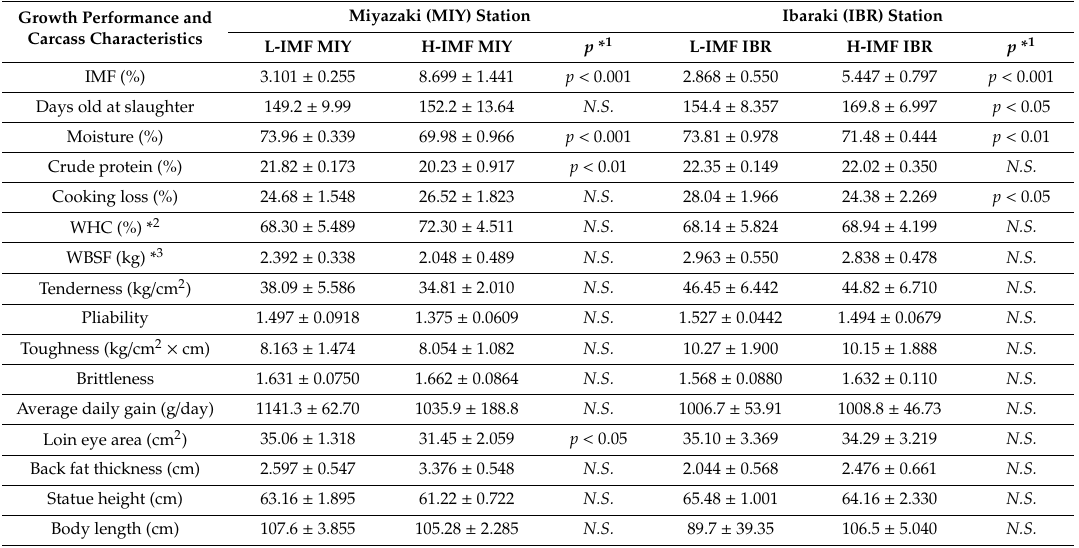
Table 1. Comparison of growth performance and carcass characteristics between high and low intramuscular fat (IMF) groups at two